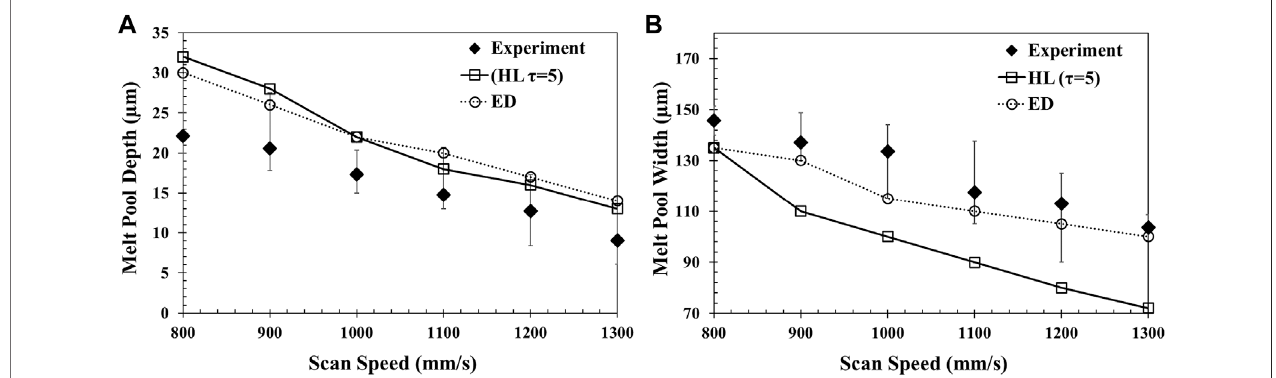
FIGURE 11 | Comparison of the experimental and HL simulation ( τ (cid:2) 5) melt pool (A) depth and (B) width for 200 W laser power.